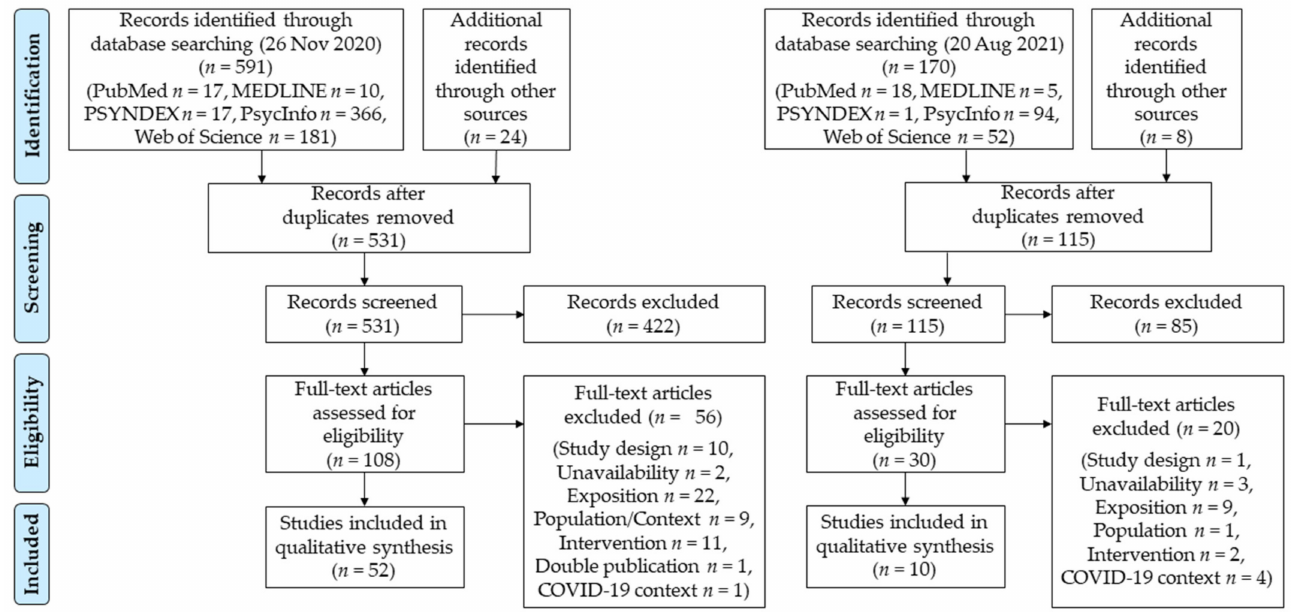
Figure 2. PRSIMA flow diagram depicting the study selection process.